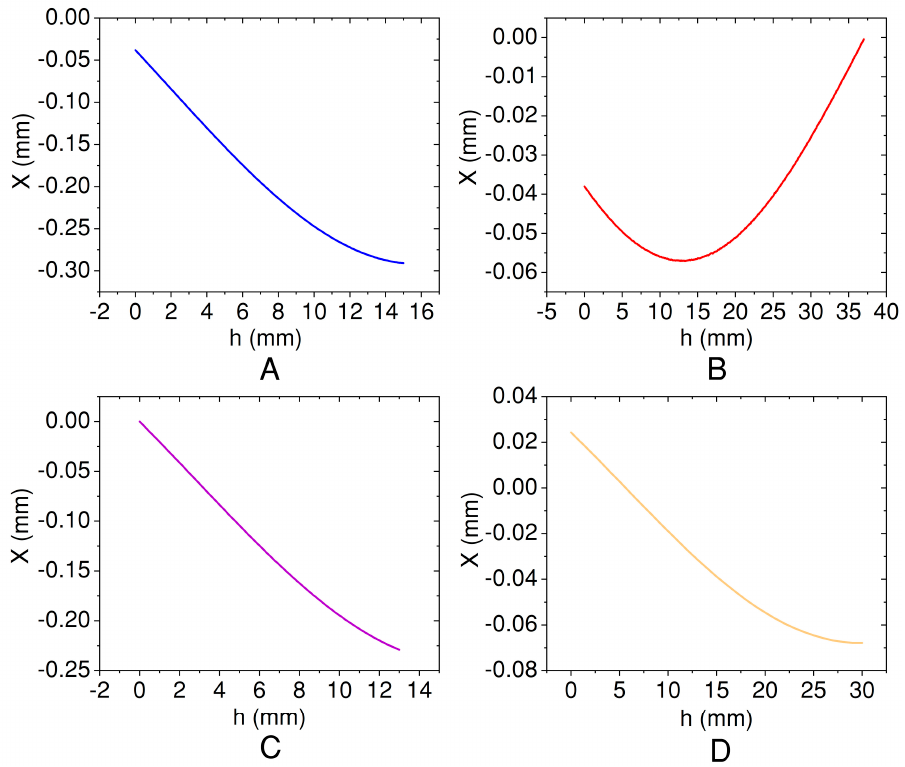
Figure 6. Abscissas distribution of ( A – D )-type end milling cutter.